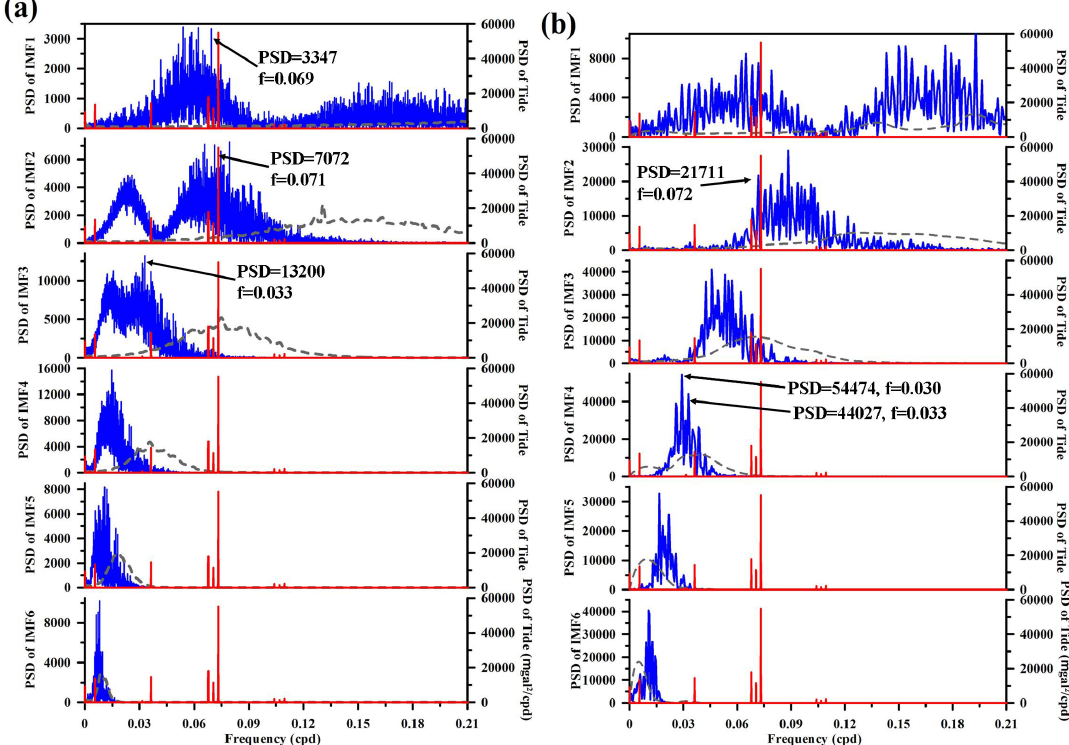
Fig. 4. The Fourier PSDs of the IMFs (IMF1 to IMF6 from top to bottom) that were extracted from (a) non-stacked and (b) stacked data of the non-declustered earthquake catalog. The red lines and gray lines represent the PSD of the Earth tides and the PSDs at a 95% confidence level from random earthquake catalogs,